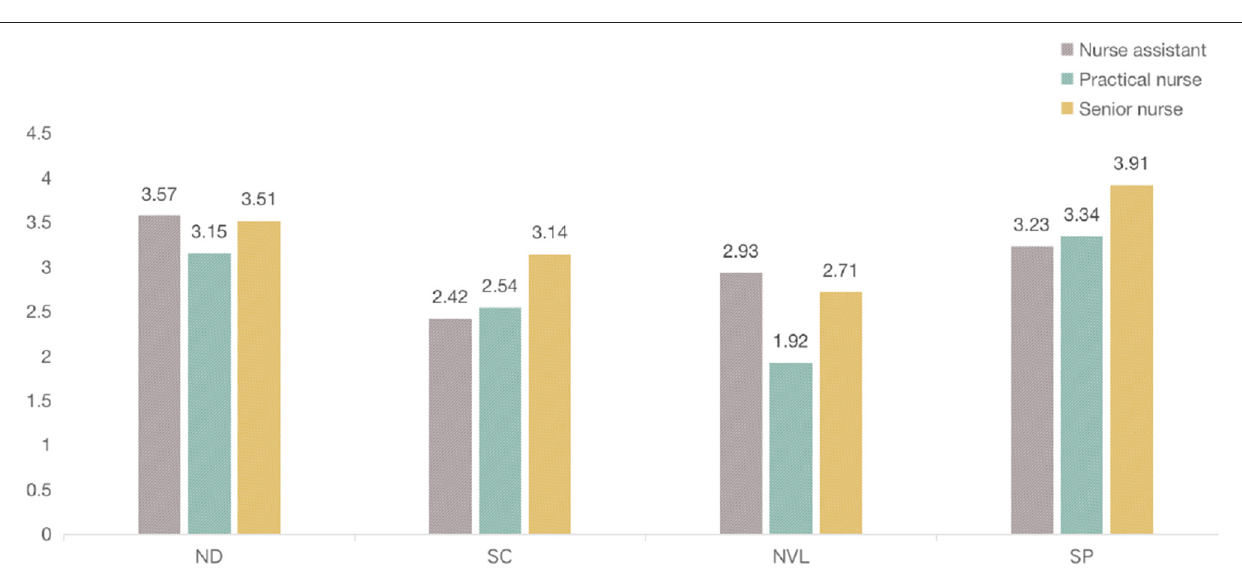
illustrate, increasing the proportion of single-bed wards would barely alleviate the fatigue because it would increase the nursing distance by enlarging the size of nursing unit. Anyhow, this study reveals the dilemma of the hospitals in the developing countries, where there is a large demand of healthcare service but limited resources. These studies may be different from the studies in the developed